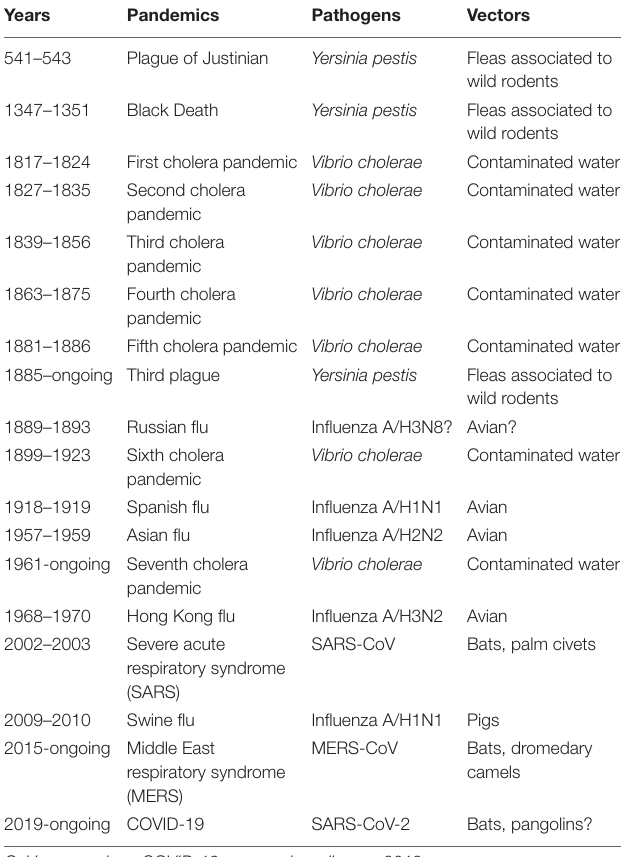
TABLE 1 | Timeline of the pandemics described in this